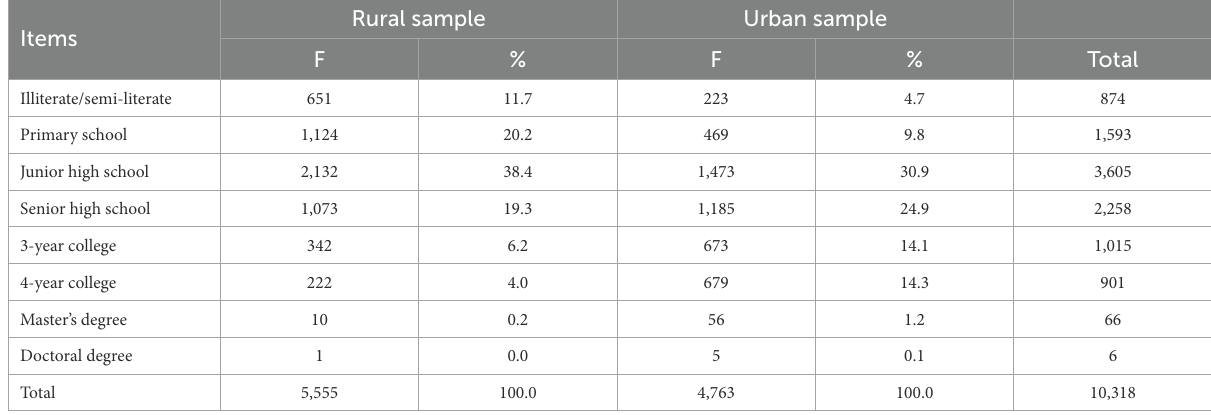
TABLE 2 Individual highest academic qualification and personal gender. Items